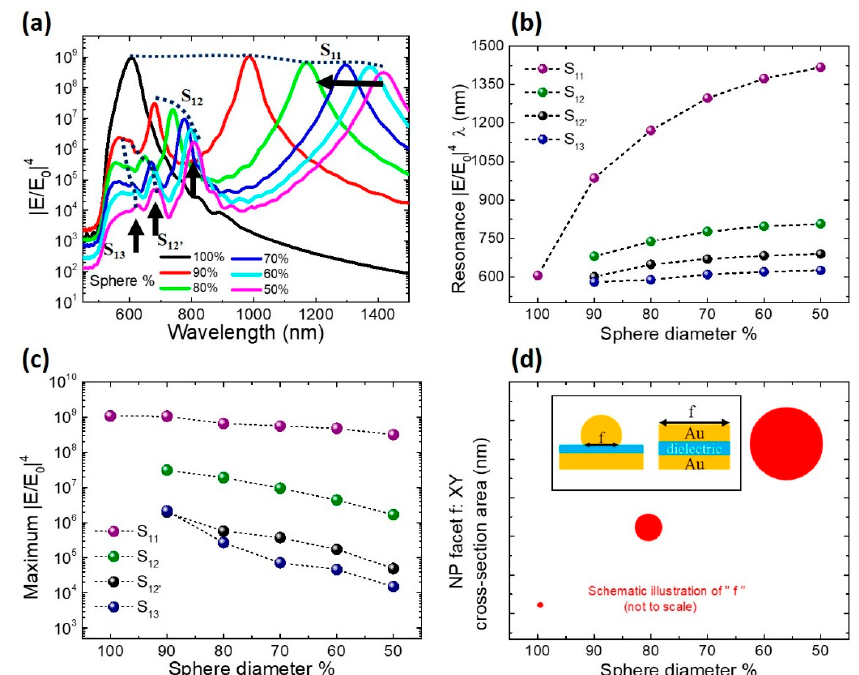
Figure 2. ( a ) Broadband | E / E 0 | 4 results for sphere diameter D % modification from 100% to 50% for NP D = 100 nm in NPOM plasmonic nanostructure. Resonance wavelengths ( b ) and near field intensities ( c ) for S 11 , S 12 , S 12 ′ and S 13 modes extracted from Figure 2a. ( d ) Schematic illustration of NP facet